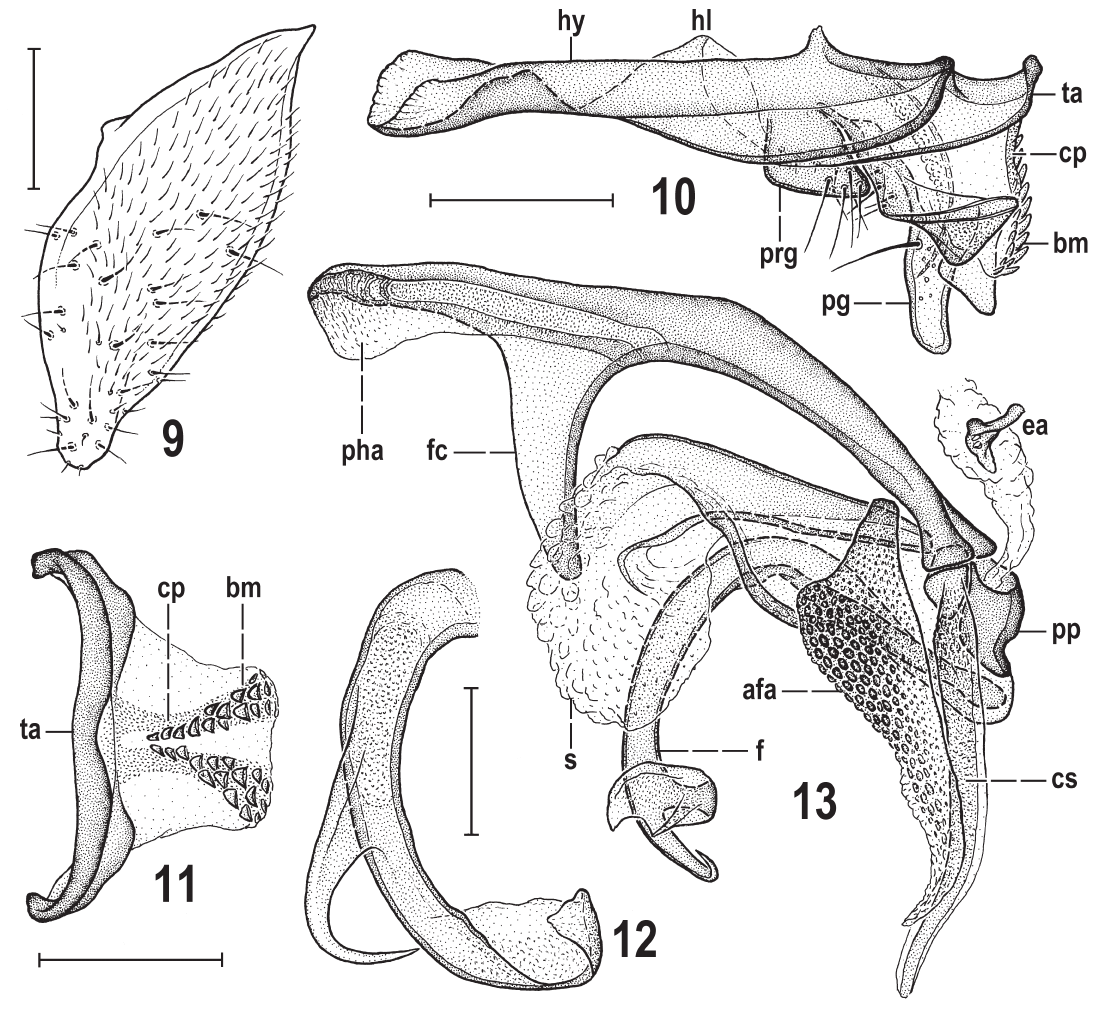
Figs 9–13. Mumetopia interfeles Roháček sp. nov., male paratypes (SMOC MIT005, MIT006). 9 . Gonostylus, posterolateroventral view (widest extension view). 10 . Hypandrial complex, lateral view. 11 . Transandrium, caudal view. 12 . Filum of distiphallus, anteroventral view. 13 . Aedeagal complex, lateral view. Scale bars: 9, 12 = 0.05 mm; 10–11, 13 = 0.1 mm. For abbreviations see Material and